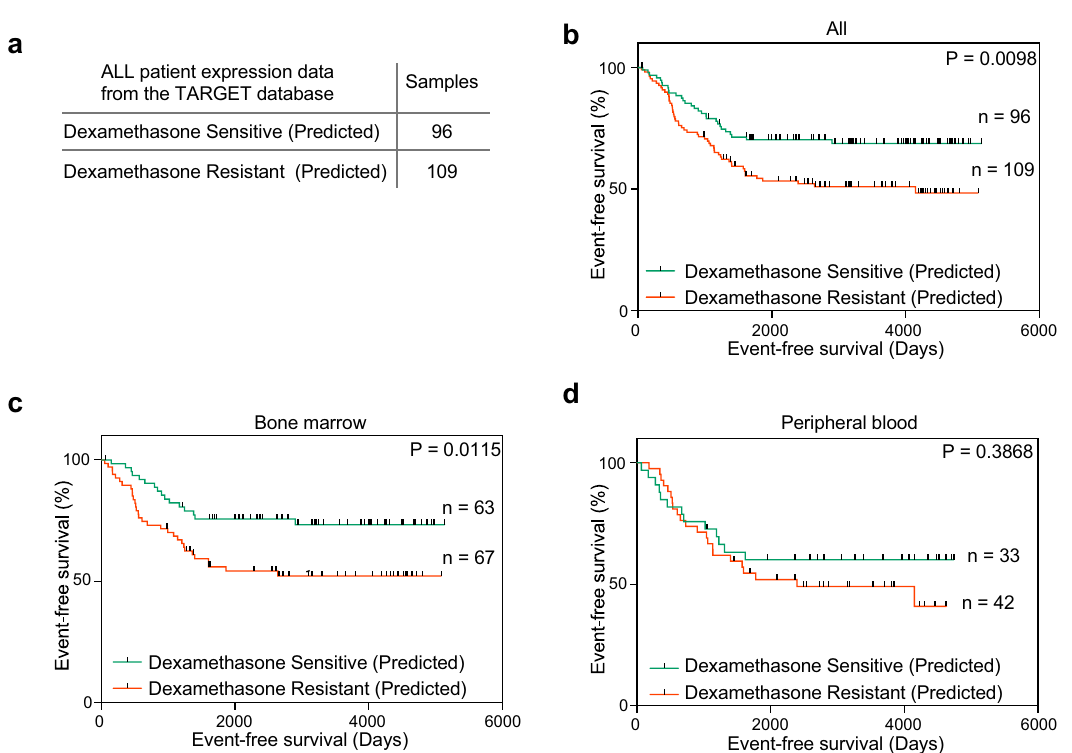
Fig. 4 Dexamethasone sensitivity prediction in ALL patient samples. The TARGET dataset for ALL was used to predict dexamethasone sensitivity. a In total 205 patient samples were used to predict dexamethasone sensitivity by the deep learning model. b Event-free survival between dexamethasone-sensitive and -resistant groups using 205 ALL patient samples was determined by GraphPad Prism. c Event-free survival for ALL patient samples collected from bone marrow. d Event-free survival for ALL patient samples collected from peripheral